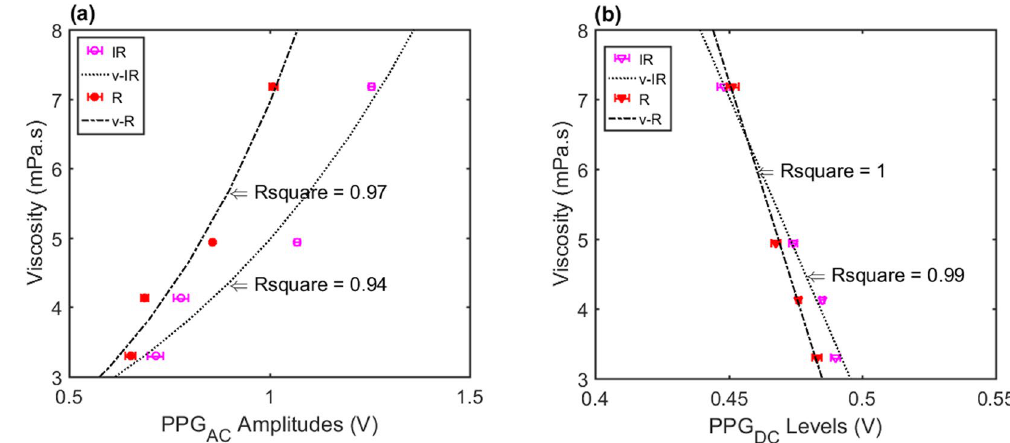
Figure 5. Regression models relating measured viscosity values with PPG components. Models created for R and IR PPG signals obtained from the in vitro experimental setup while changing pumping frequencies at 4 set-points. ( a ) Exponential regression model for viscosity values versus the amplitudes of PPG AC . ( b ) Linear regression model for viscosity values versus levels of PPG DC